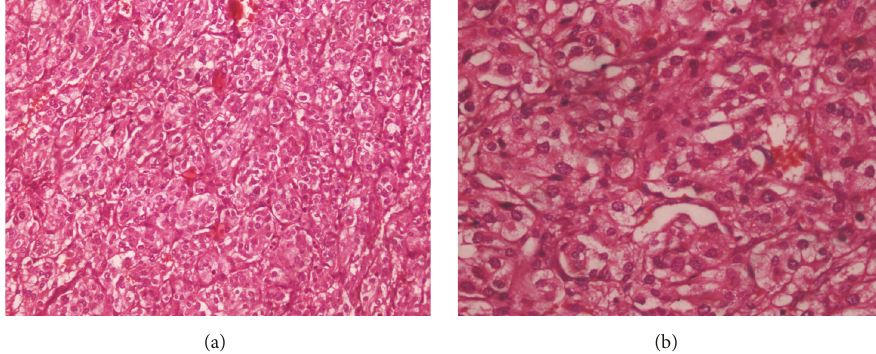
Figure 3: Biopsy showing oval to polygonal tumor cells with abundant granular eosinophilic to clear cytoplasm and oval nucleus. The nests of tumor cells (zellballen pattern) are separated by sustentacular cells ((a) × 200; (b) ×